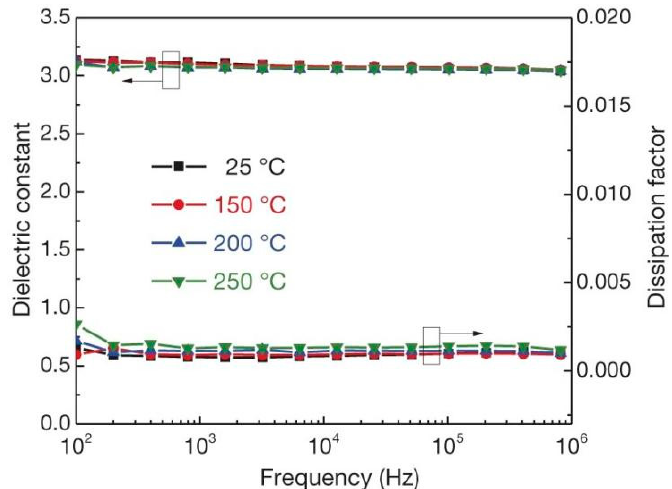
Figure 4. Frequency dependence of the permittivity and dissipation factor of c-BCB/BNNS with 10 vol% of BNNSs at different temperatures. Error bars show standard deviation. Reprinted with permission from [12]. Copyright 2015, Springer Nature.